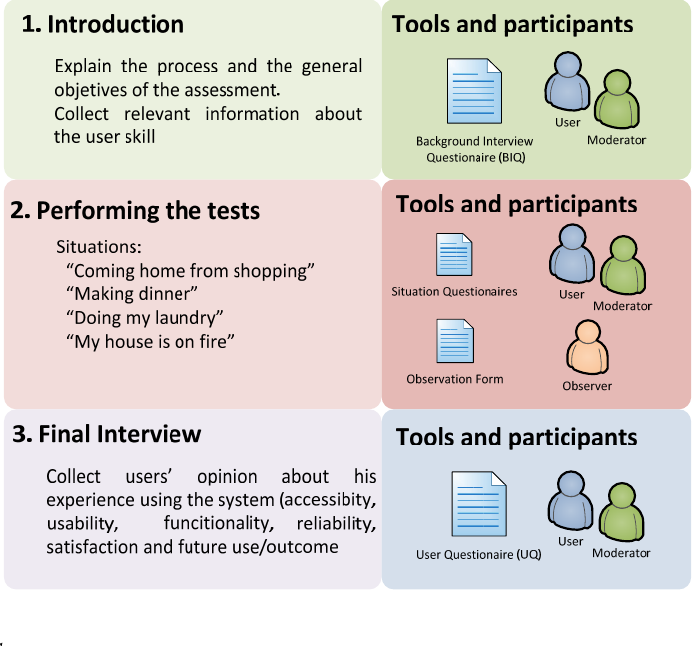
Figure 9. Evaluation process.